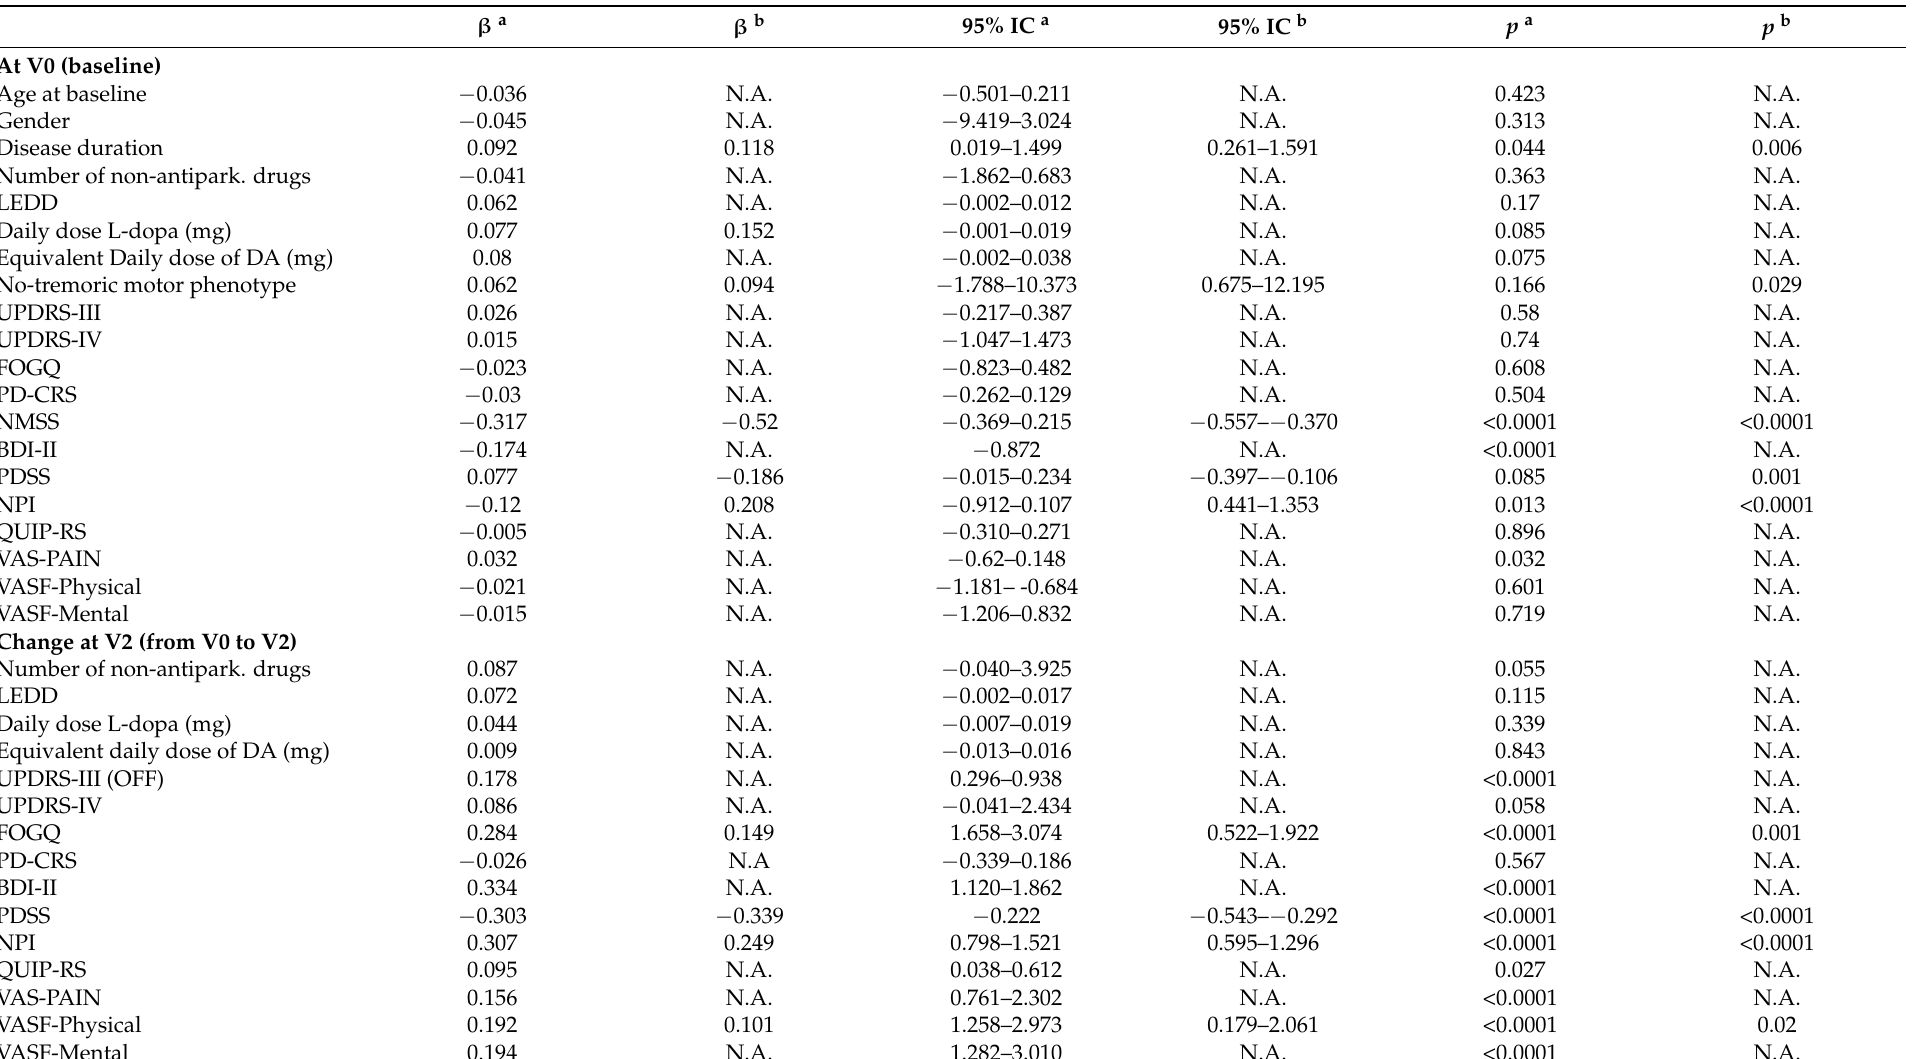
Table 3. Linear regression model about factors associated with global burden progression after 2-year follow-up (change in the NMSS total score from V0 to